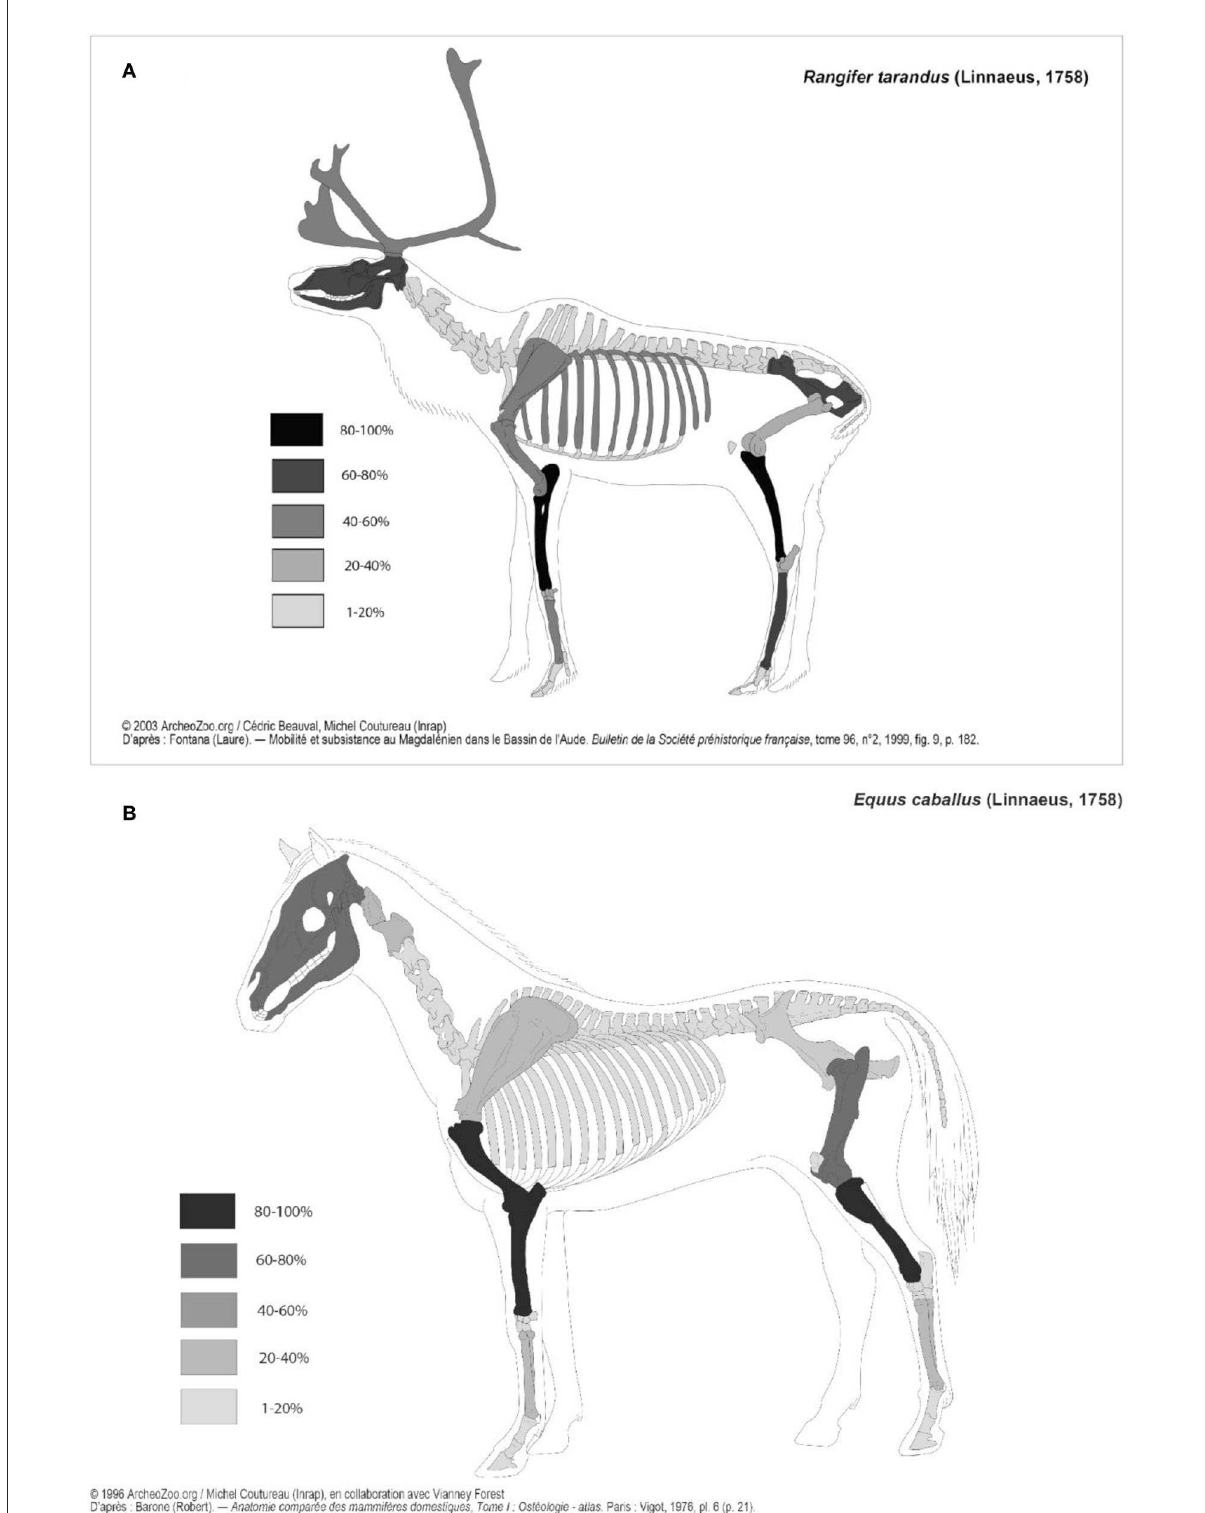
FIGURE6 (A) Reindeer skeletal part representation of Chez-Pinaud horse remains expressed in %MAU, image modified from © 2003 ArcheoZoo.org / Cédric Beauval, Michel Coutureau (Inrap) D’après : Fontana (Laure). — Mobilité et subsistance au Magdalénien dans le Bassin de l’Aude.